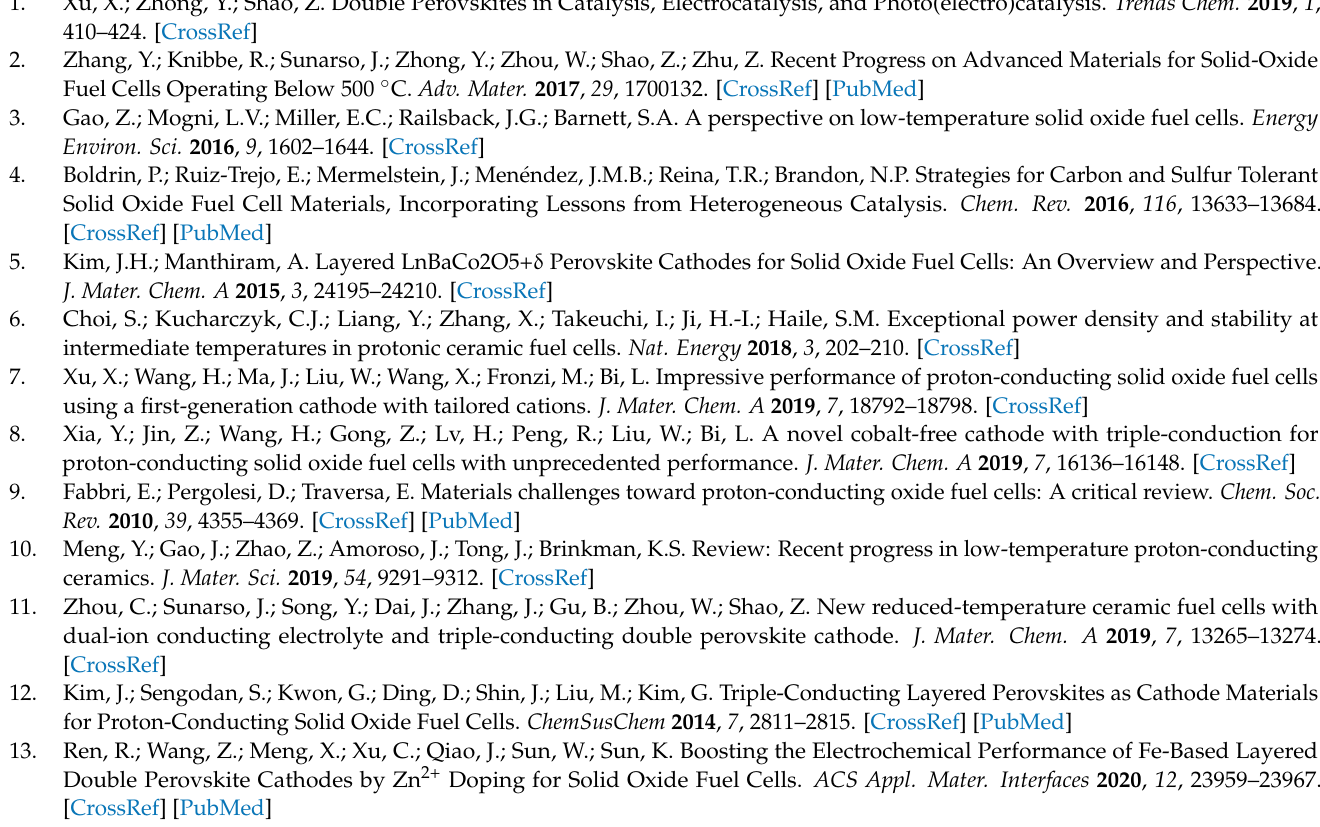
coefficient; Figure S2. EIS plots of a symmetric PBF|SDC|PBF cell; Figure S3. I − V and I − P curves of PBF cathode based single-cell; Figure S4. (a) Impedance spectra for single cells, (b) calculated value of Rp, Ro, and Rt; Figure S5. (a) SEM micrographs of the cell, (b) microstructure of PBF cathode; Figure S6. Energy Dispersive Spectrum (EDX)